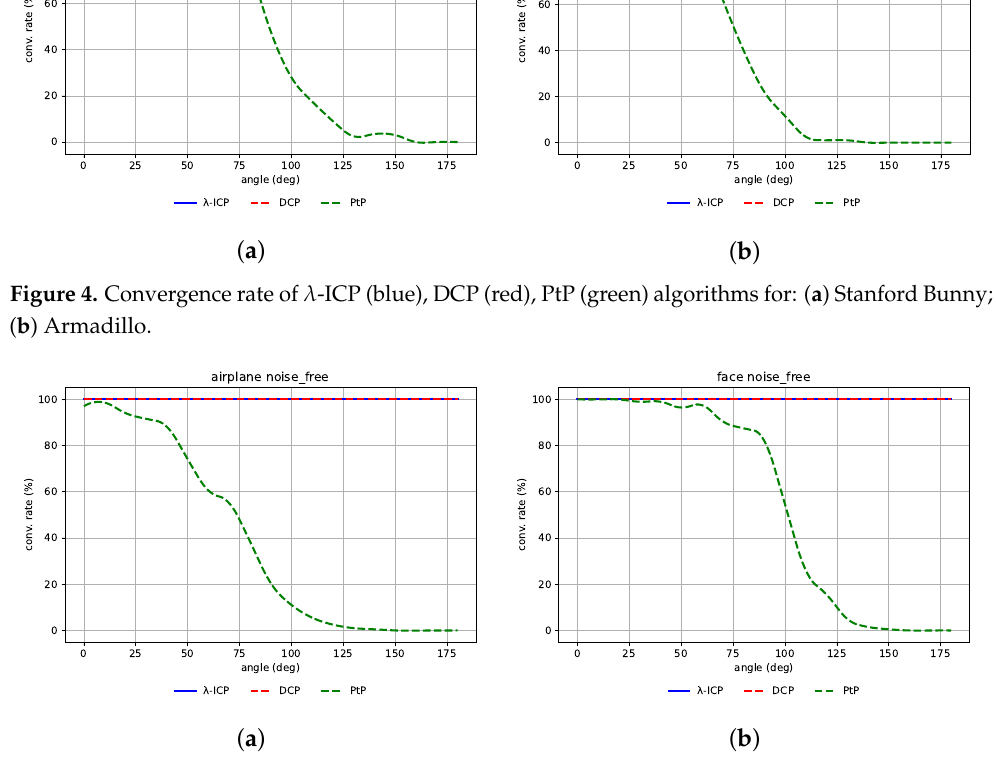
Figure 5. Convergence rate of λ -ICP (blue), DCP (red), PtP (green) algorithms for: ( a ) airplane; ( b ) human face.